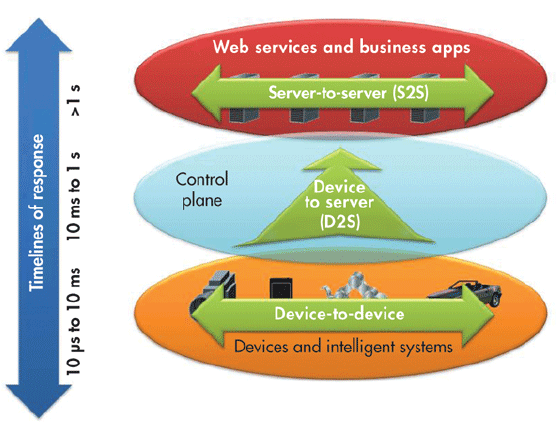
Figure 4. Response times intervals accepted as efficient.